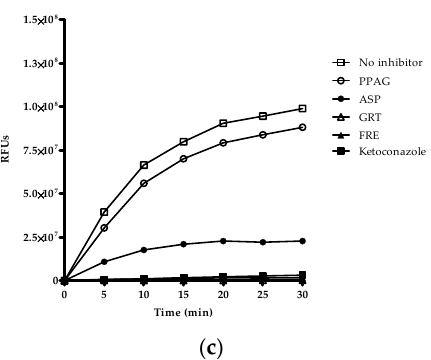
Figure 2. Qualitative screening of drugs, compounds and extracts based on their inhibitory potency of Vivid ® CYP2C8, CYP2C9, and CYP3A4 enzymes. Inhibitory activity of PPAG ( Z -2-( β - D -glucopyranosyloxy)-3-phenylpropenoic acid), ASP (aspalathin), GRT (unfermented rooibos extract), and FRE (fermented rooibos extract) at 100 µg/mL for ( a ) CYP2C8, and ( b ) CYP2C9, and 200 µg/mL for ( c ) CYP3A4. The test samples were co-incubated with NADPH and substrate for 30 min. Quercetin, sulfaphenazole, and ketoconazole at 10 µM were included as positive inhibitors. Data are presented as RFU (relative fluorescence units) for two independent assays done in duplicate ( n = 4).